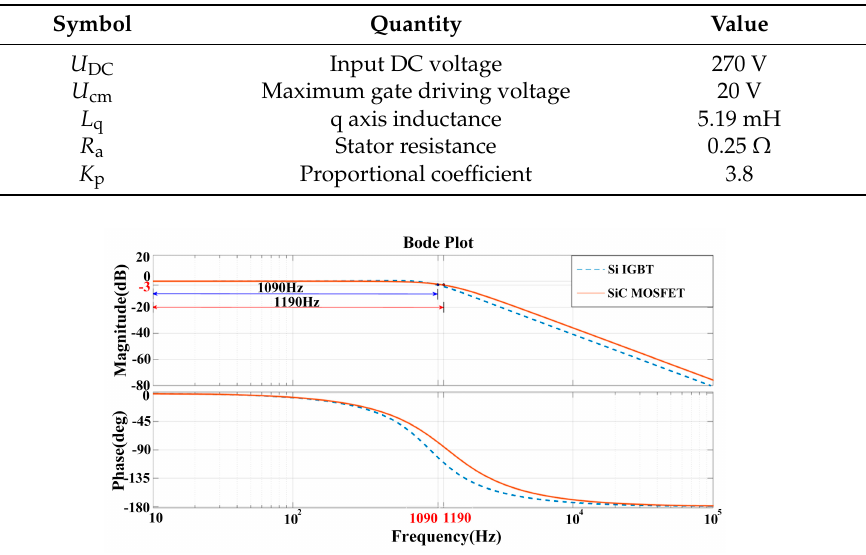
Figure 7. Bode plot of the inverter fed PMSM system with different power devices.